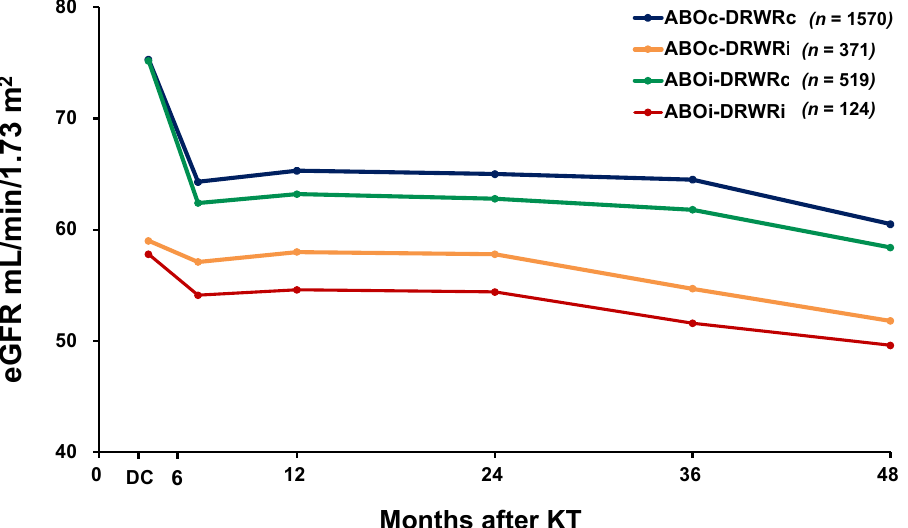
Figure 2. Graft function from hospital discharge to 48 months after KT. p -values of ANOVA and pos hoc analyses at each time point are provided in the Table S2. DC, discharge; KT, kidney transplantation.